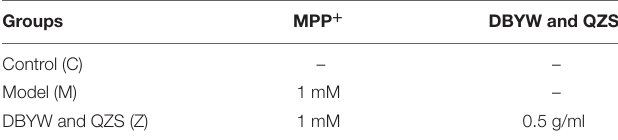
TABLE 2 | Experimental groups and